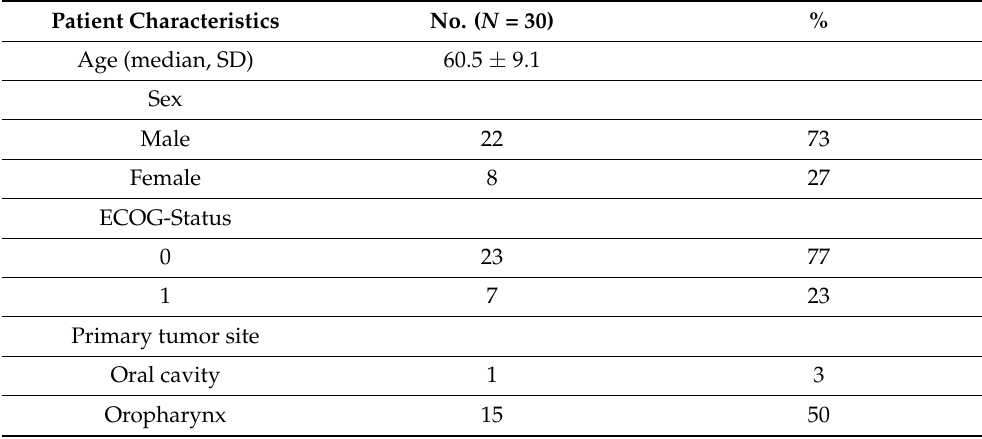
Table 2. Patients